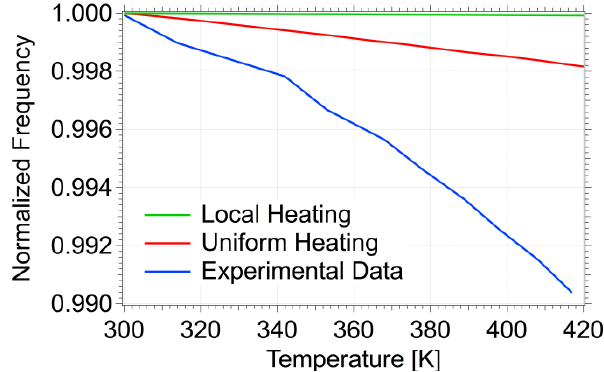
Figure 5. Sensor calibration of the unloaded cantilever: shift in resonance frequency as a function of the temperature. The red and green lines show the results obtained by mathematical simulation for uniform and local heating conditions, respectively, while the blue one shows the experimental